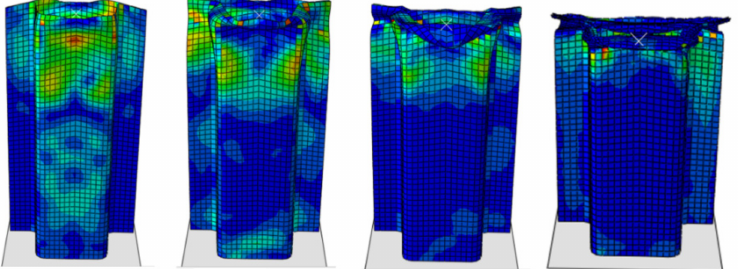
Figure 11. Example of dynamic crushing of structure for 2 kJ test (numerical simulation). This figure shows the progressive crushing of the composite